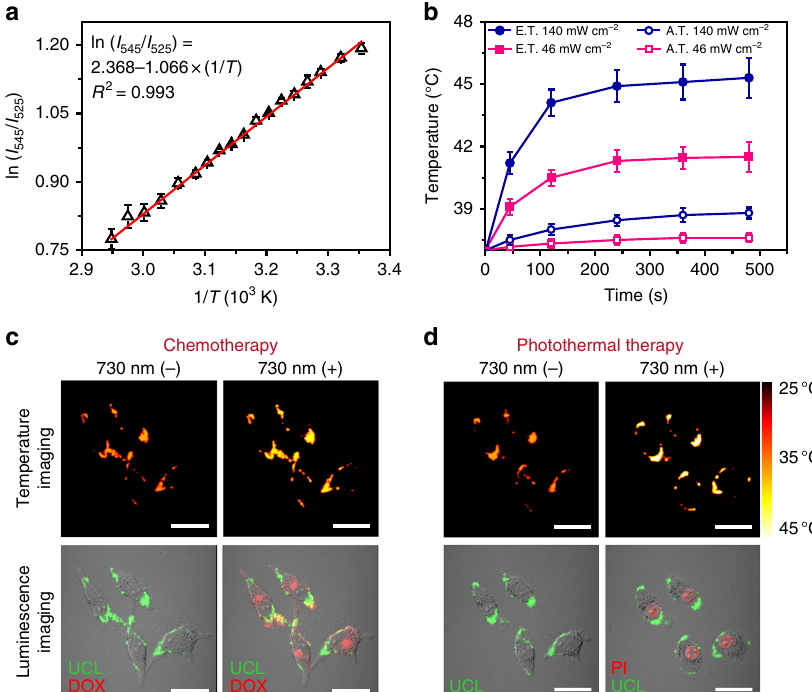
Fig. 5 Eigen temperature sensing and drug release at cell level. a A plot of ln( I 525 / I 545 ) versus 1/ T to calibrate the thermometric scale for TR-UCNS in MIA PaCa-2 cells. Average values of I 525 / I 545 under different temperatures were given to fi t the calibration curve based on three repeated measurements of